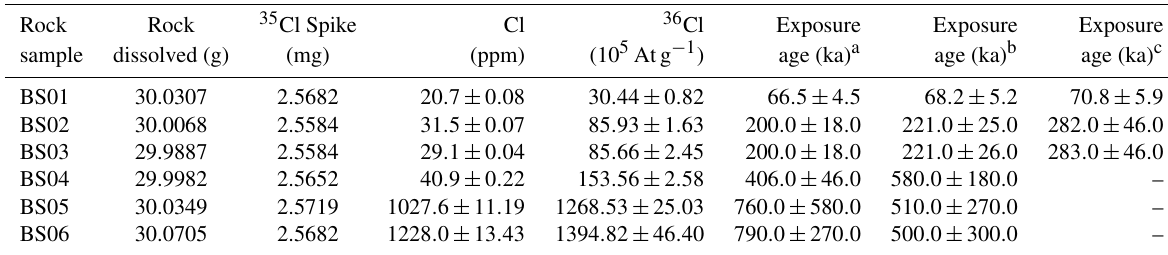
Table C2. Cosmogenic 36 Cl data and surface exposure ages of the rock samples from the Sanetti Plateau. Rock Rock 35 Cl Spike Cl 36 Cl Exposure Exposure Exposure sample dissolved (g) (mg) BS01